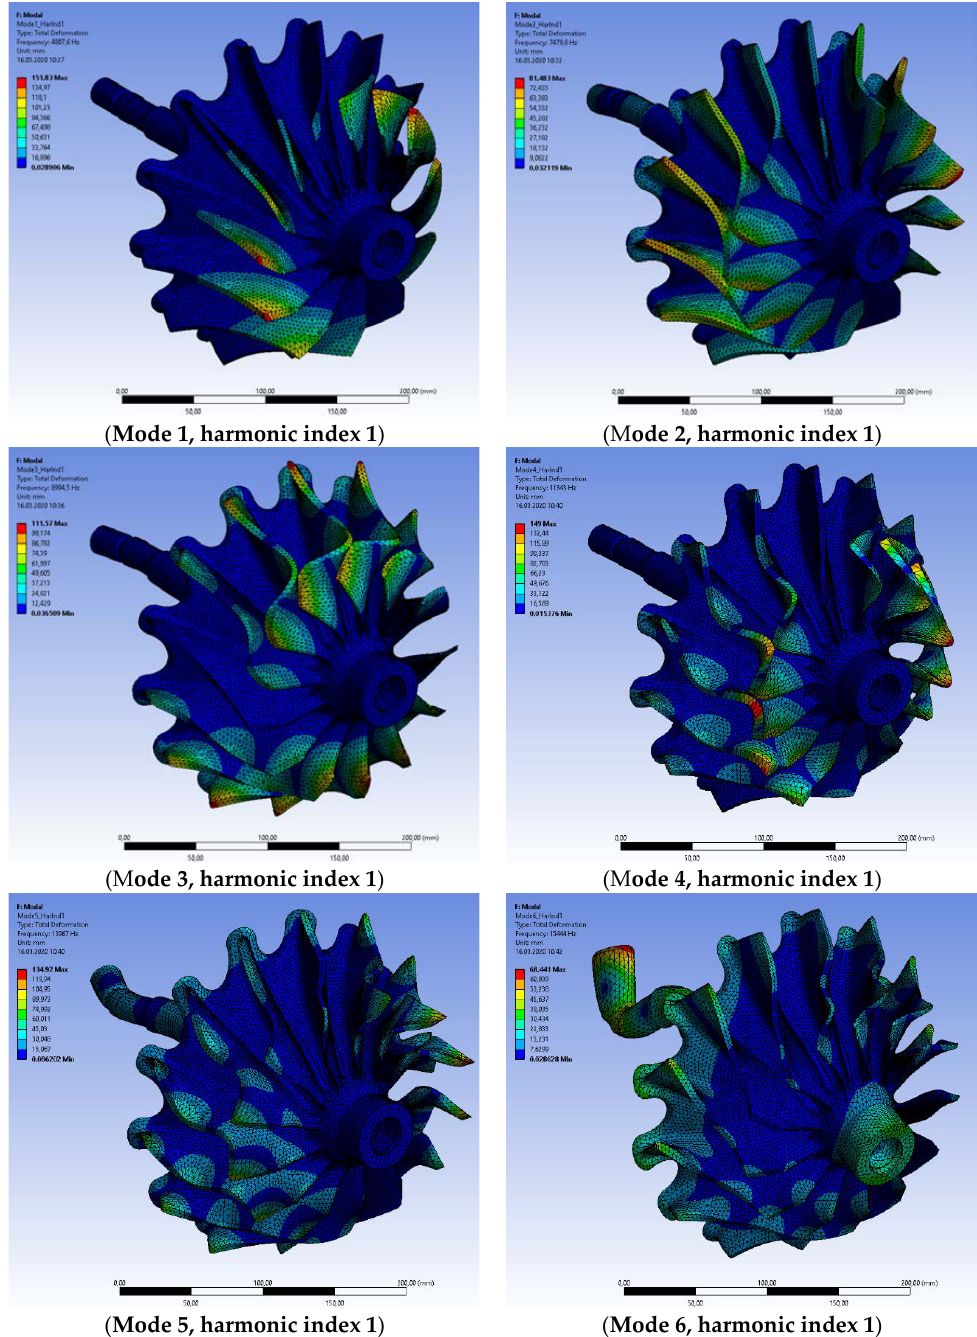
Figure 8. Examples of computed modal shapes of the turbocharger turbine wheel.